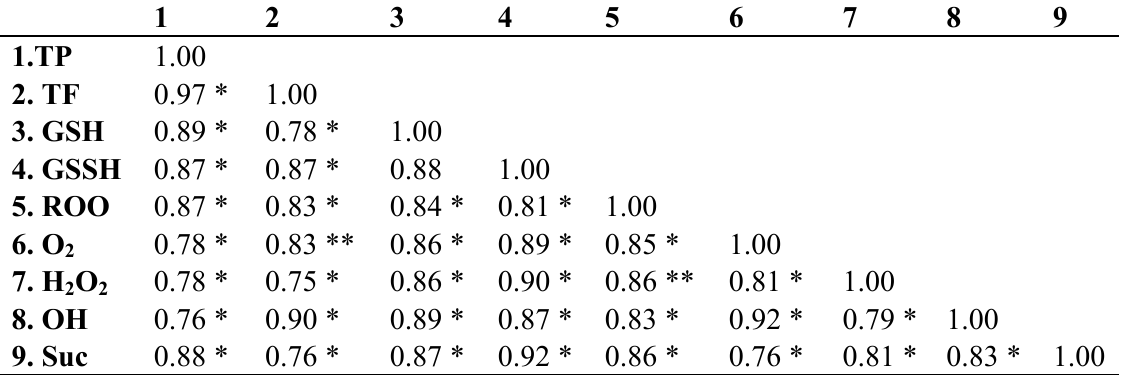
Table 3. The correlationship between total phenolics (TP), total flavonoid (TF), Gluthatione (GSH). Oxidized Gluthatione (GSSH), peroxide radicals (ROO), superoxide radicals (O hydrogen peroxide (H O ) hydroxyl radicals (OH) and sucrose (Suc) in the 2 2